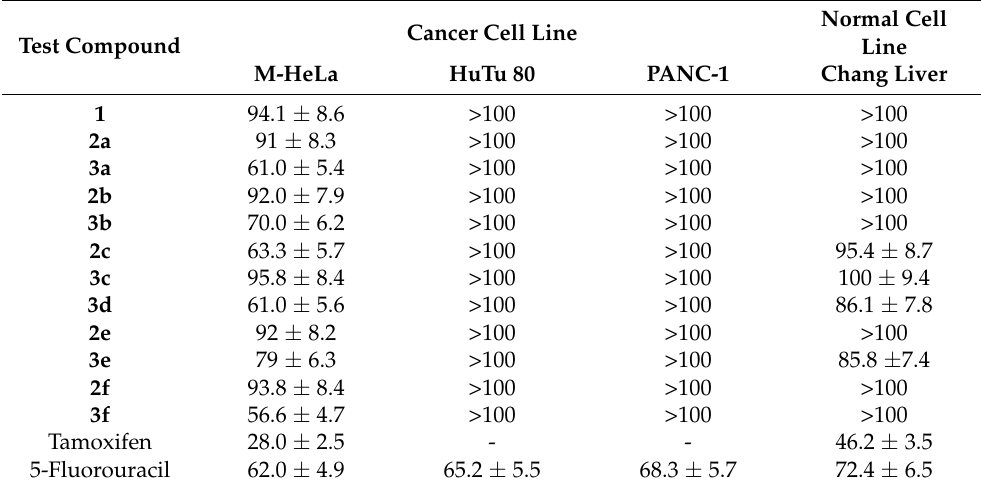
Table 3. Cytotoxic effects (IC 50 µ M) of test compounds on the cancer and normal human cell lines *.